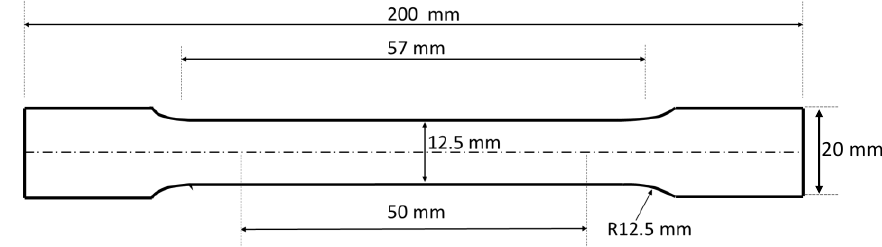
Figure 2. ASTM E8 tensile specimen geometry, material thickness 0.1 mm [41].